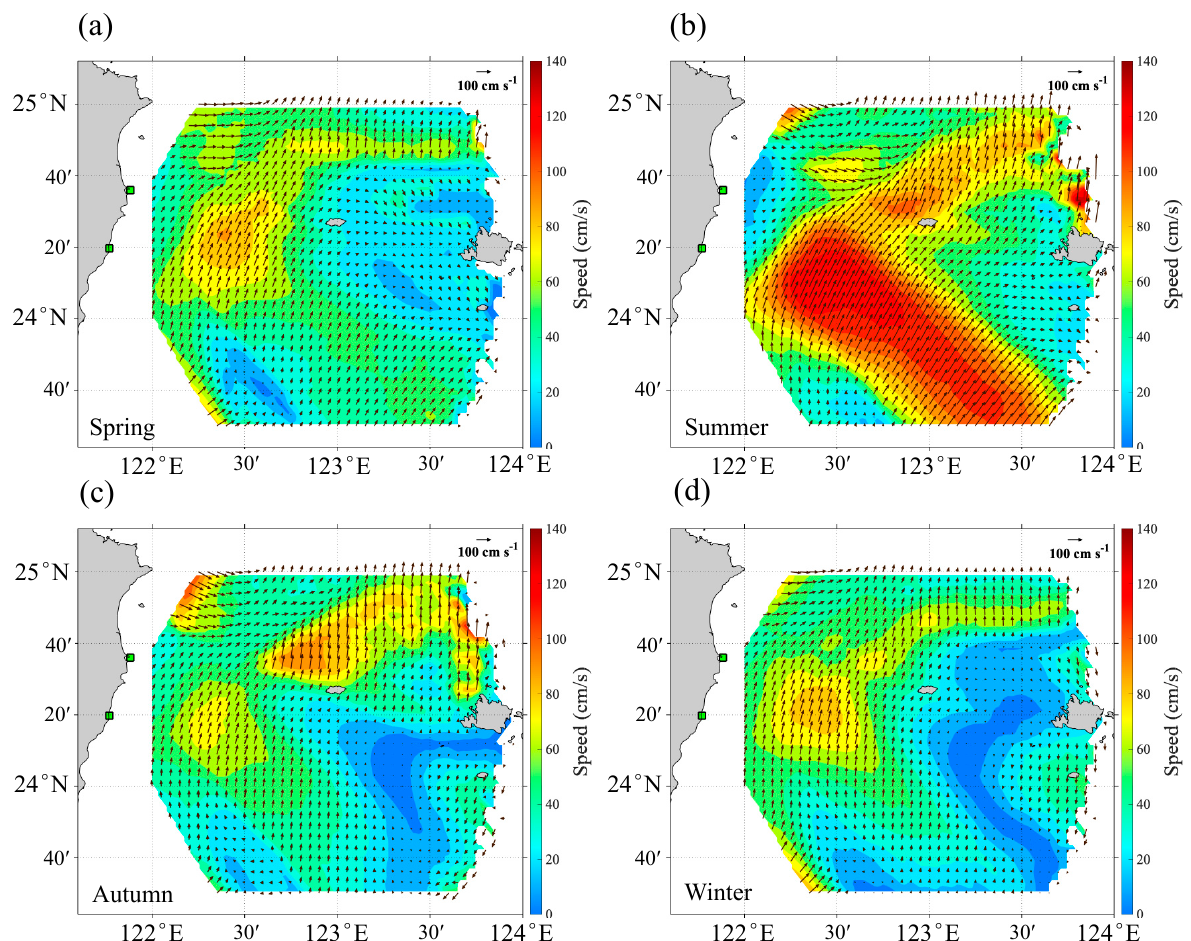
Figure 3. Seasonal current velocities (vectors) in the region off of northeastern Taiwan. The green point in the north is the SUAO station, and the southern point is the HABN station; the flow direction is indicated by the arrow vectors, and the contour plots of velocities are for the flow rates. ( a ) Spring, ( b ) Summer, ( c ) Autumn, and ( d ) Winter .